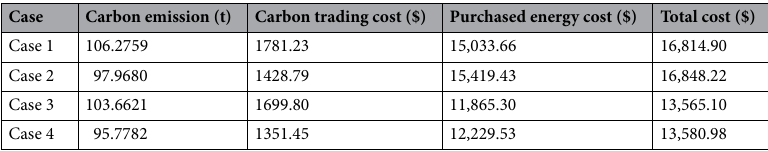
Table 6. Carbon emission and cost comparison of four cases.